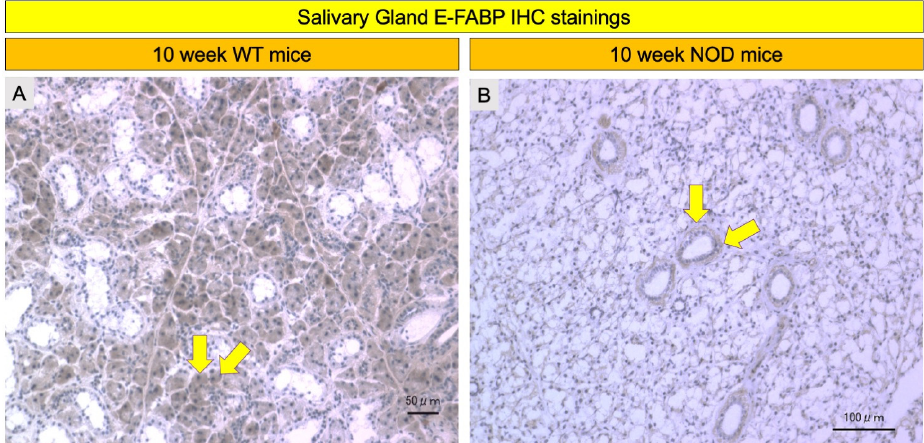
Figure 4. Comparison of E-FABP immunohistochemistry in the salivary gland between the wild-type (WT) mice and the NOD mice. Representative immunohistochemistry images showed less intense immunostaining in the acinar epithelium of the NOD mice ( B ) when compared with the WT mice ( A ) (yellow arrows). IHC: immunohistochemistry.